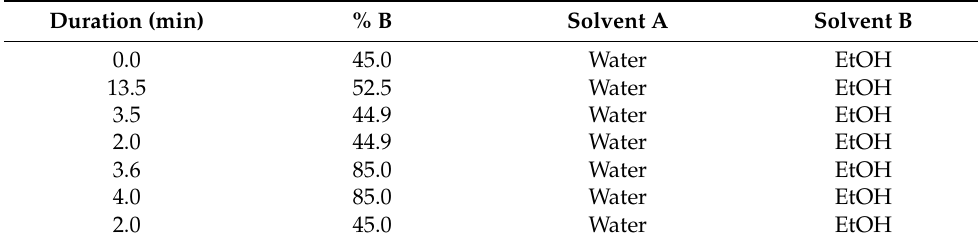
Table 2. The gradient regimen of mobile phase for separating capsaicin and capsaicinoids.